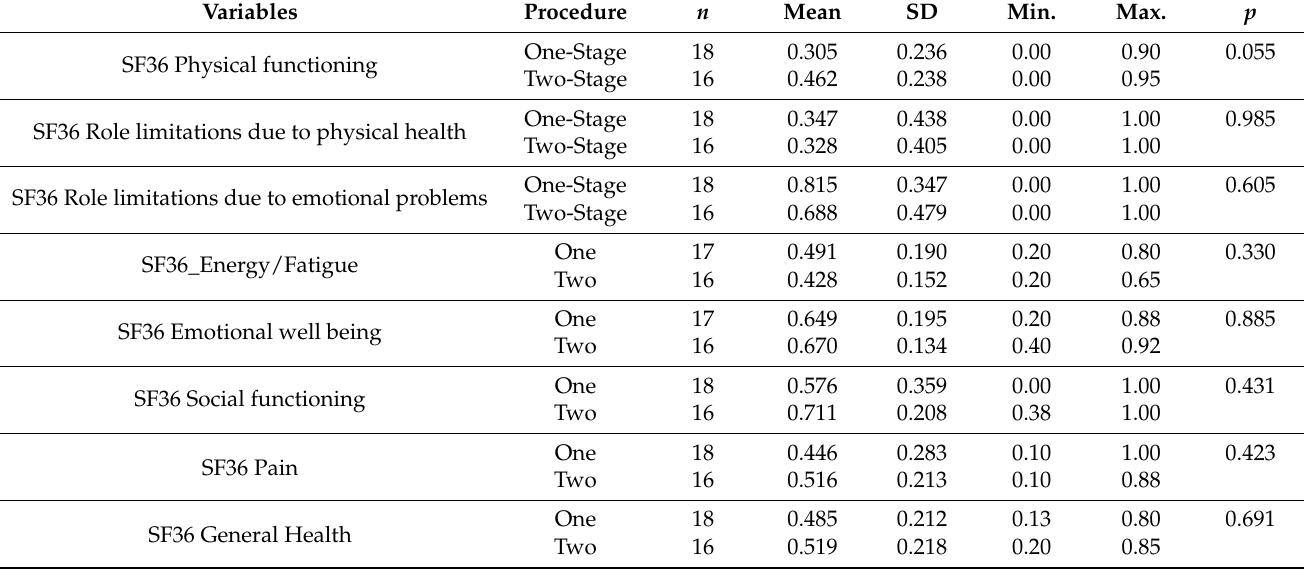
Table 5. Detailed information on the results of the SF-36